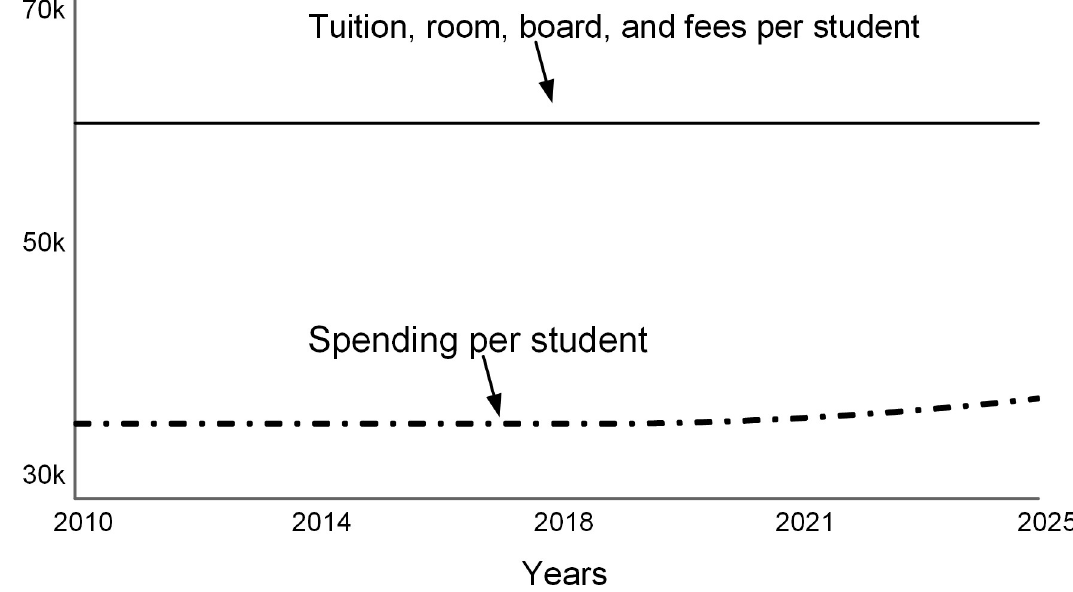
Fig 12. Metrics per student.